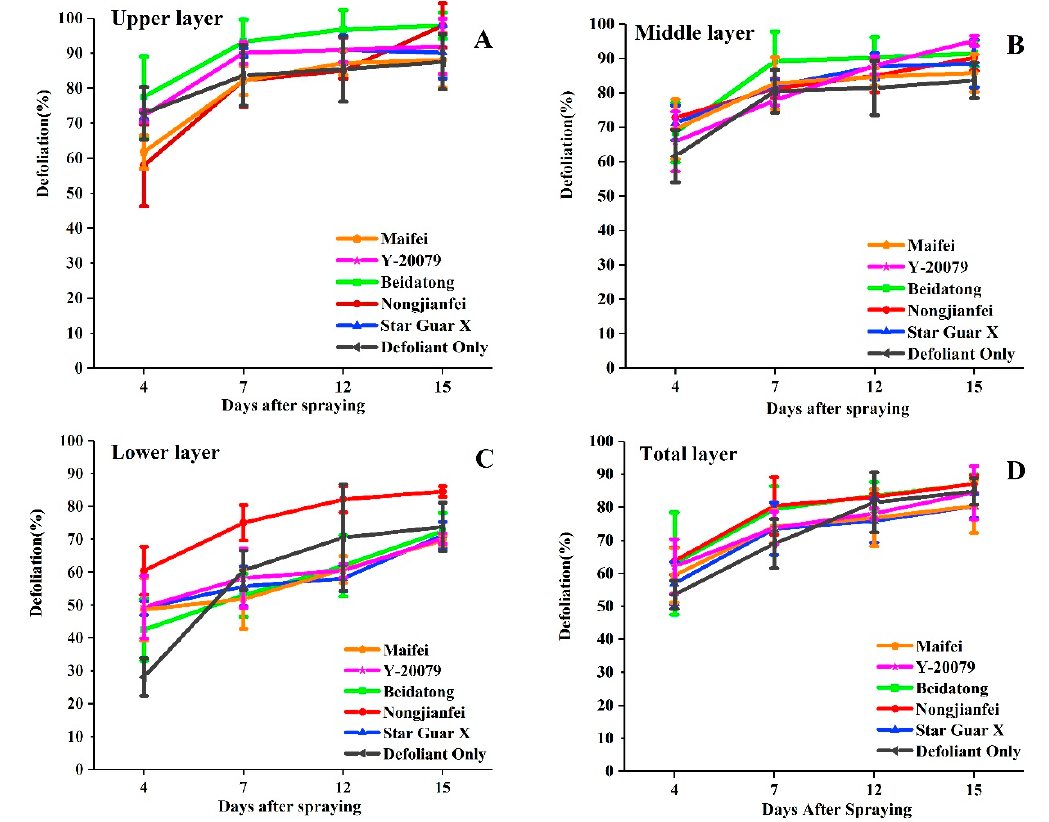
Figure 4. E ff ect of aviation spray adjuvants on the defoliation e ff ect of cotton sprayed by UAV. ( A ) Cotton upper layer, ( B ) cotton middle layer, ( C ) cotton lower layer and ( D ) cotton total layer. CK: Defoliate only; Maifei: 150 mL / ha; Beidatong: 300 mL / ha; Nongjianfei: 150 mL / ha; Y-20079: 150 mL / ha; and Star Guar X: 75 mL / ha.